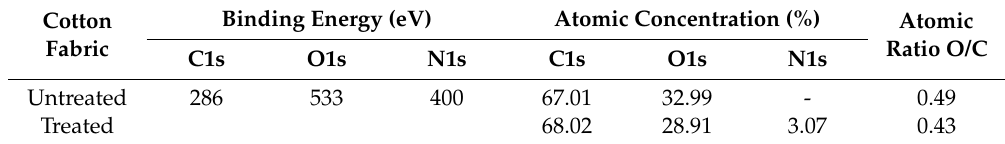
Figure 10. XPS spectrums of untreated cotton fabrics ( a ) and treated cotton fabrics ( b ). Table 4. Chemical composition of untreated and treated cotton fabrics.